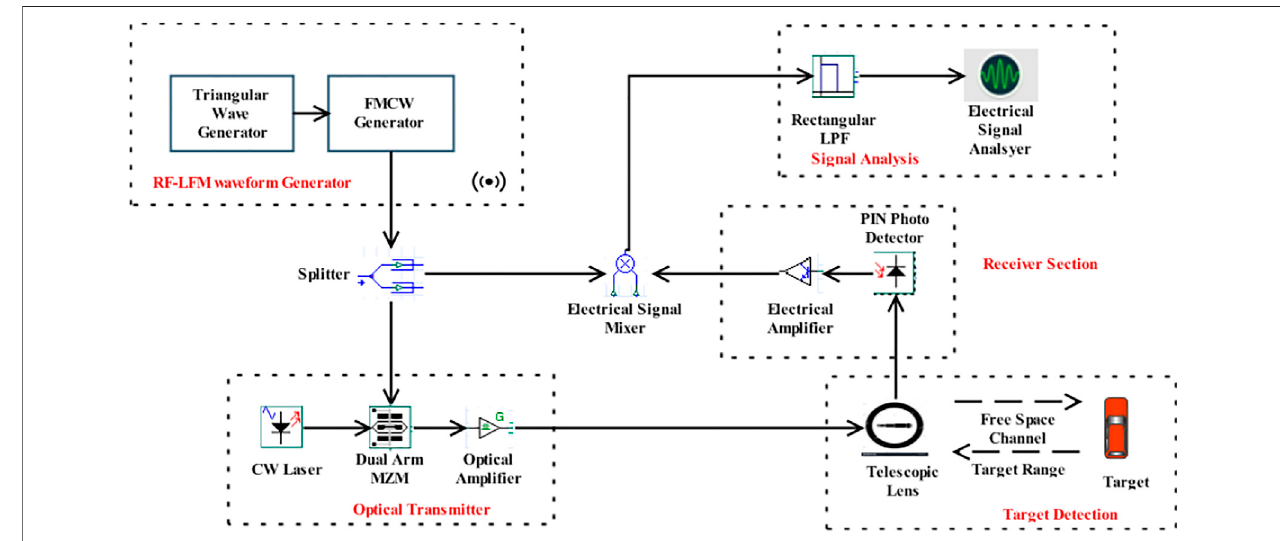
FIGURE 2 | Proposed FMCW photonic radar for autonomous